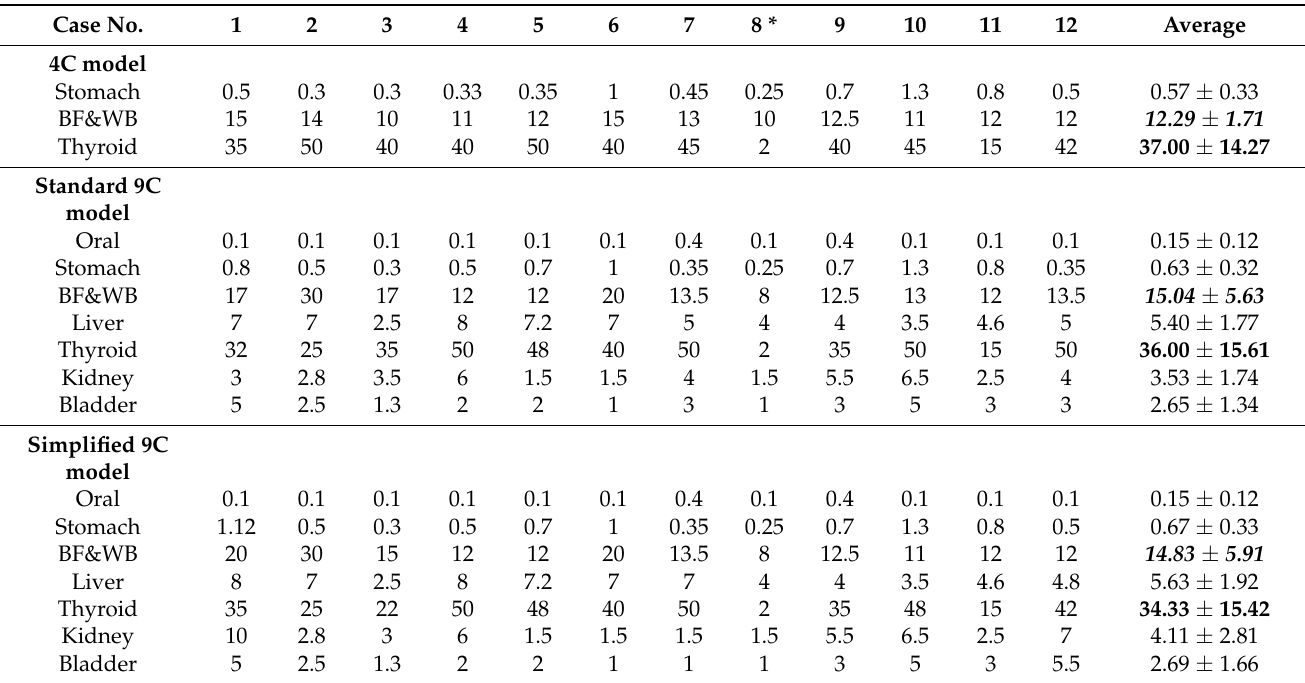
Table 2. The derived biological half-life values and averages for simultaneous time-dependent differential equations (cf. Equations (1)–(9)) as adopted in this work. The calculation results are theoretical estimations of the time-dependent quantity of I-131 in various compartments for the twelve patients according to the MATLAB calculations. * Case no. 8 was excluded from the calculation of average values.